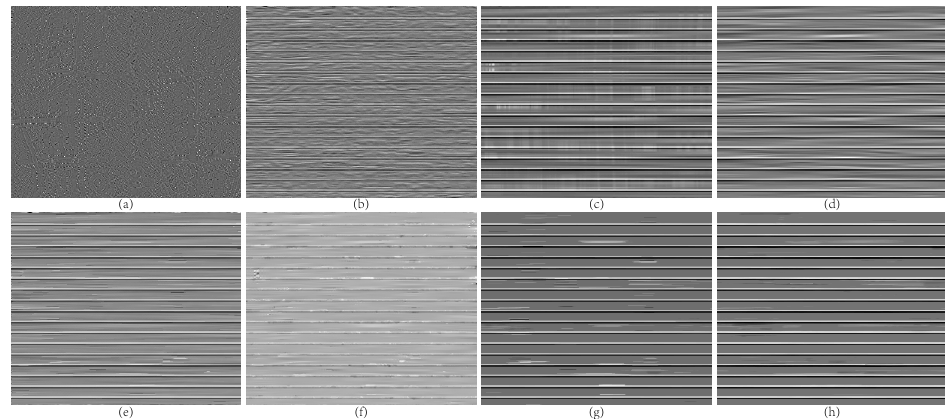
Figure 10. Results of comparison methods for simulated stripe Washington DC Mall hyperspectral data S4. ( a ) BM3D; ( b ) SNRCNN; ( c ) GF-based; ( d ) WAFT; ( e ) UV; ( f ) HUTV; ( g ) SUV; ( h ) WDSUV.